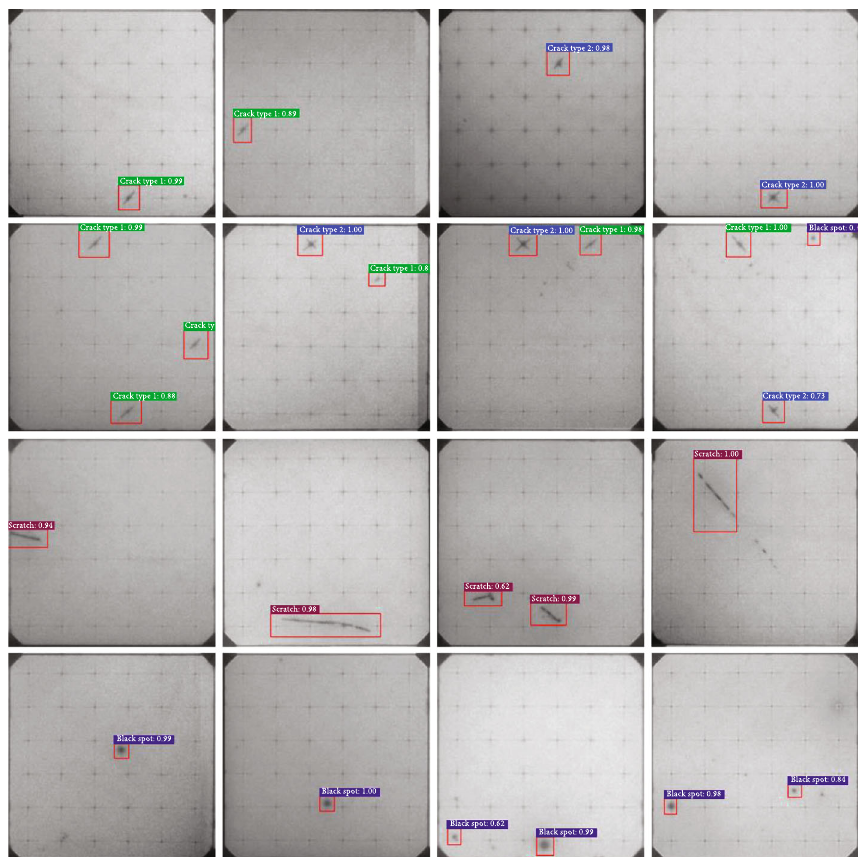
Figure 16: The e ff ect of improved defect